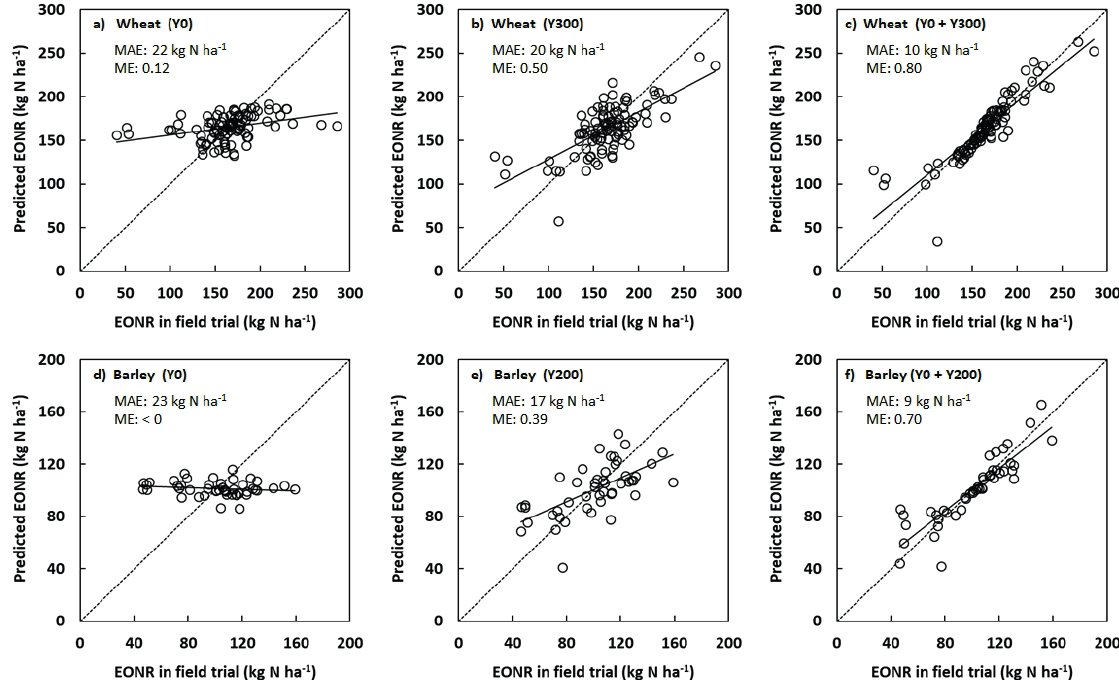
Fig. 2. Predicted values of economic optimal nitrogen rate (EONR) plotted against EONR determined in field trials for wheat (a-c) and barley (d-f). The predictions are from the k-fold cross-evaluation of models. The models were linear models with different predictor sets (given in brackets). The dashed line is the 1:1 line and the solid line shows a linear regression model between the predicted EONR and the EONR determined from experimental data. Y0 = yield at 0 kg N ha -1 , Y200 = yield at 200 kg N ha -1 and Y300 = yield at 300 kg N ha -1 . MAE = mean absolute error; ME = Nash-Sutcliffe modelling 237